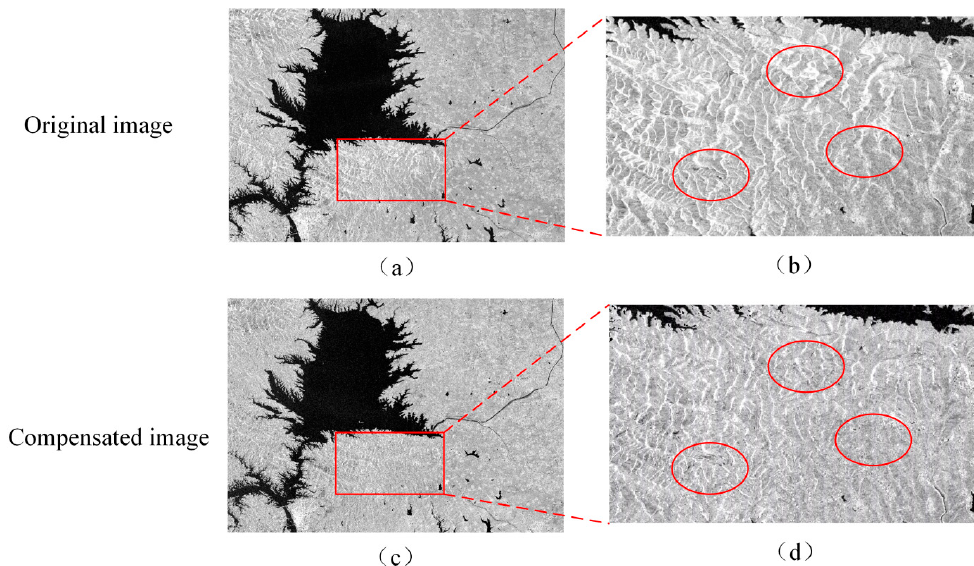
Figure 12. Gafen-3 image and compensated geometric distortion area: ( a ) Gaofen-3 original HV polarized image; ( b ) enlarged area in ( a ); ( c ) compensated image of Gaofen-3 HV polarized image; ( d ) enlarged area in ( c ).